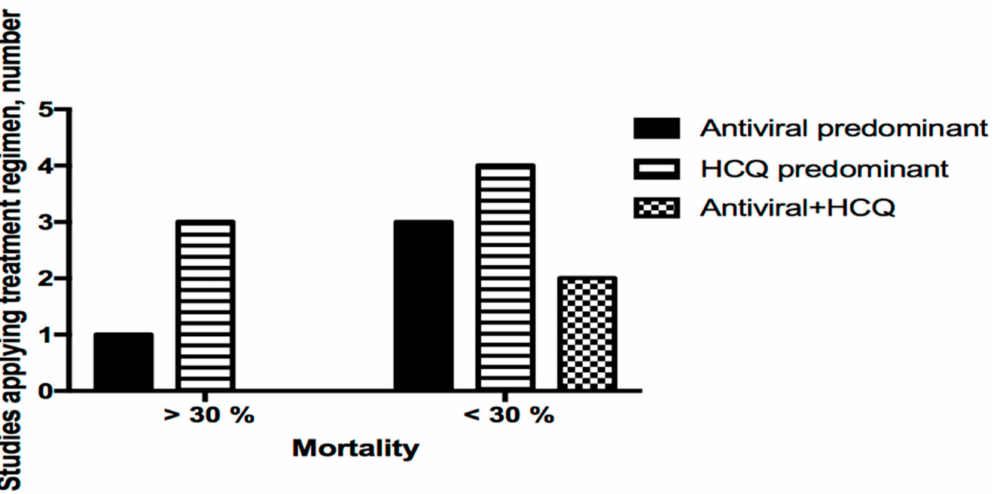
Figure 3. Treatment regimen used and proportion of high mortality (>30%) in different studies. Three main patterns were identified among 11 studies. Chi-square test, p =